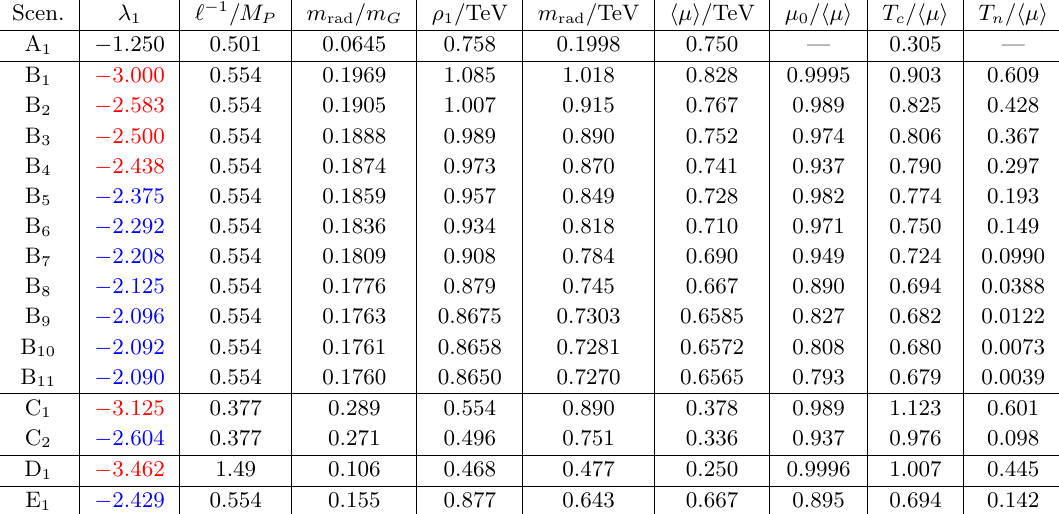
Table 1 . List of benchmark scenarios de(cid:12)ned by the classes in eqs. (4.12){(4.16) and the input values of (cid:21) 1 (second column). The outputs obtained in each scenario are presented from the third column on. The foreground red [blue] color on the value of (cid:21) 1 indicates that the corresponding phase transition is driven by O (3) [ O (4)] symmetric bounce solutions. In scenario A 1 there is no phase